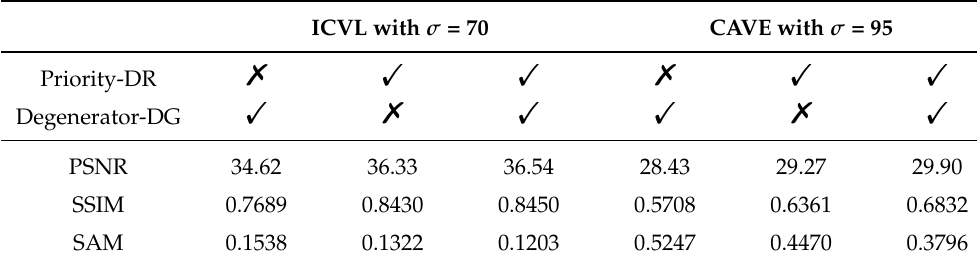
Table 9. Ablation study on training strategies. Priority-DR denotes priority dual regression strategy. Degenerator-DG denotes the Degenerator is trained with DGInfo.